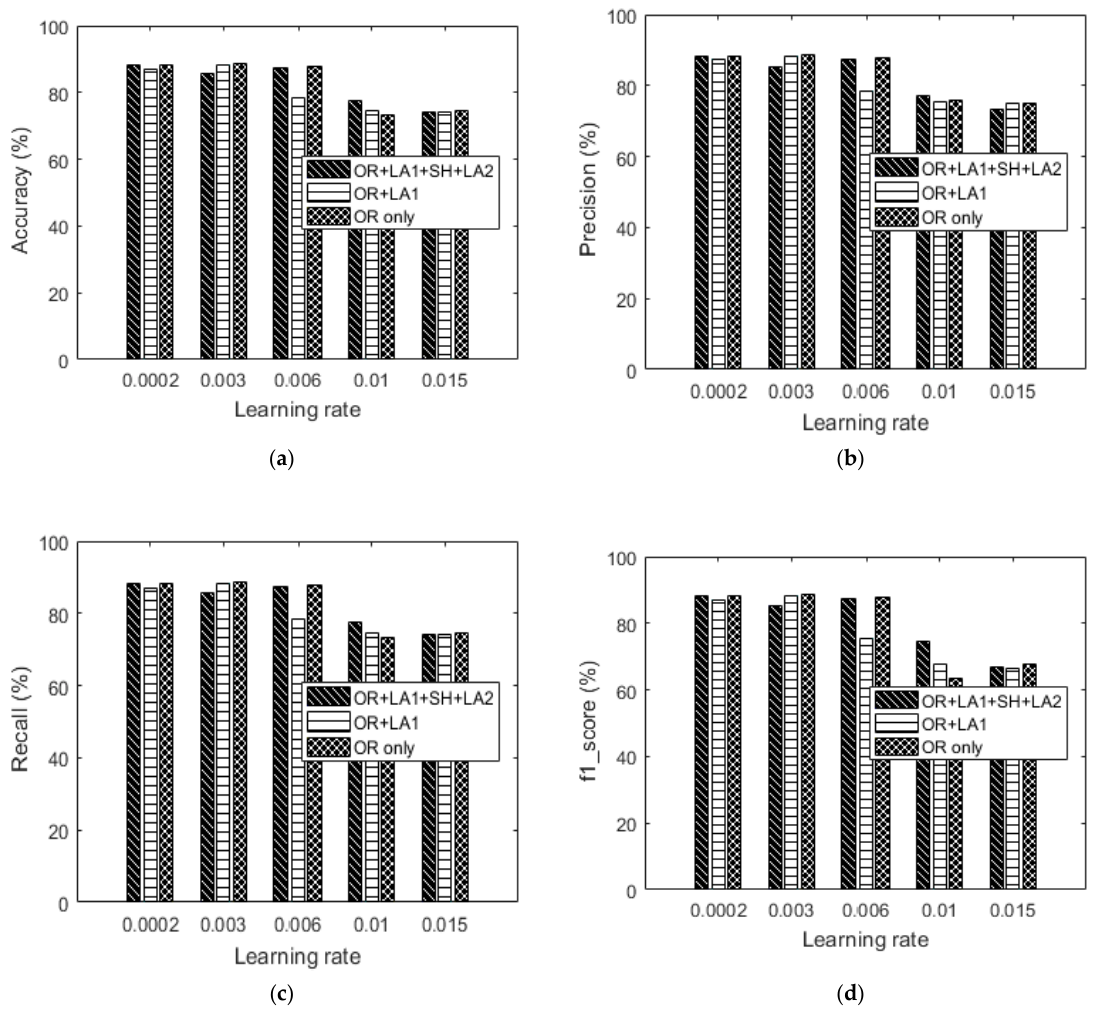
Figure 16. 200-feature vector dataset: ( a ) Accuracy versus learning rate, ( b ) precision versus learning rate, ( c ) recall versus learning rate and ( d ) f1_score versus learning rate.